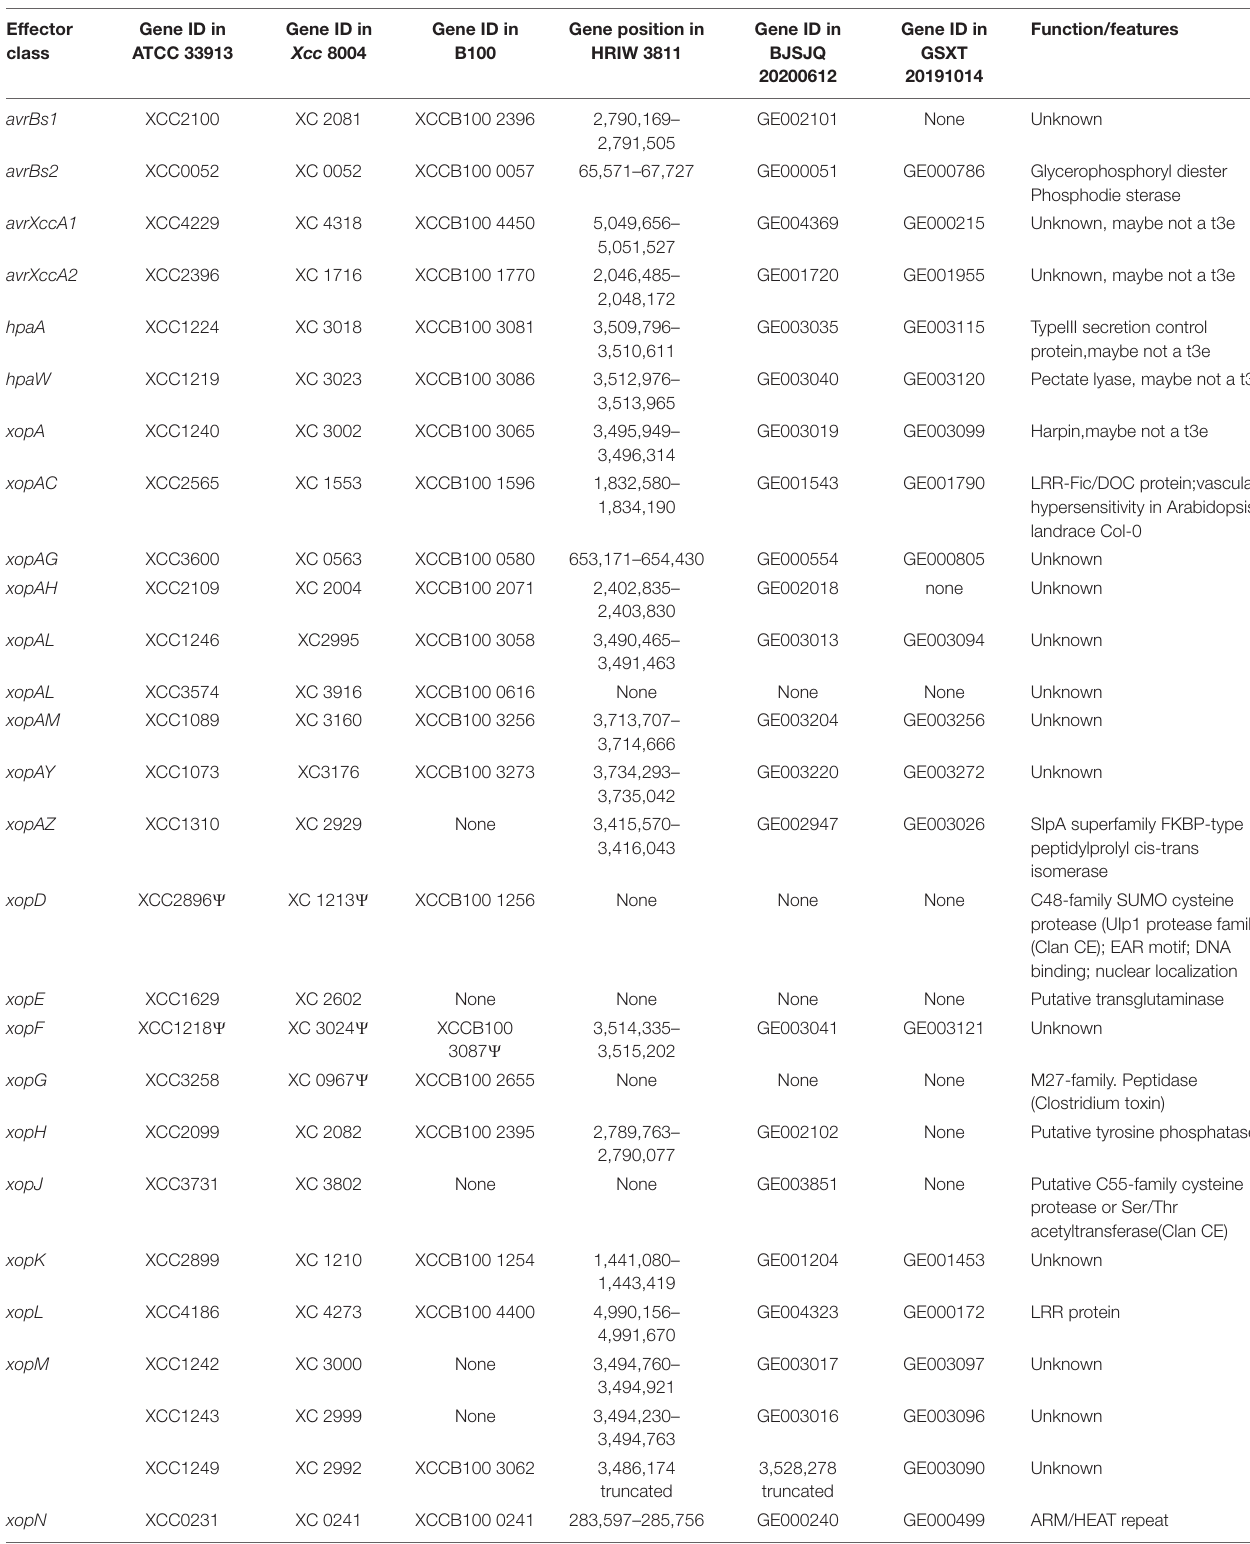
TABLE 4 | Effector repertoire of ATCC 33913, Xcc 8004, B100, HRIW 3811, BJSJQ20200612 and GSXT20191014